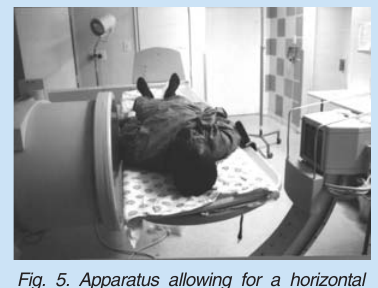
Fig. 5. Apparatus allowing for a horizontal position of the image intensifier and X-ray tube is essential to assess the possible bene- ficial result of swallowing in the supine posi-